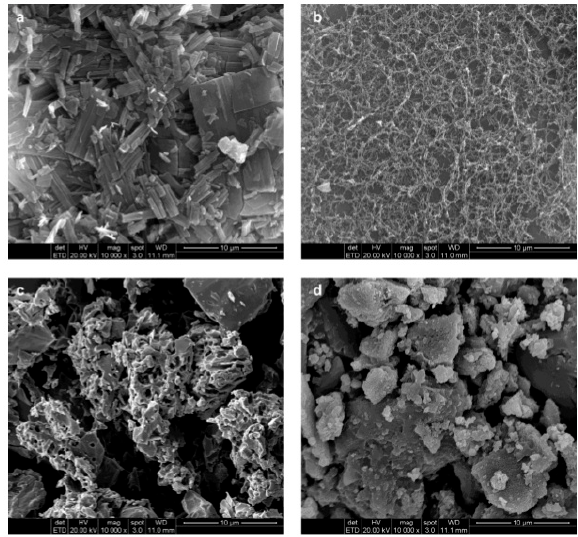
Figure 5. SEM photomicrographs of ( a ) free PCX ( b ) PCX:HP- β -CD, ( c ) PCX:6-O-Capro β CD, and ( d ) PCX:PC β CDC6 inclusion complexes